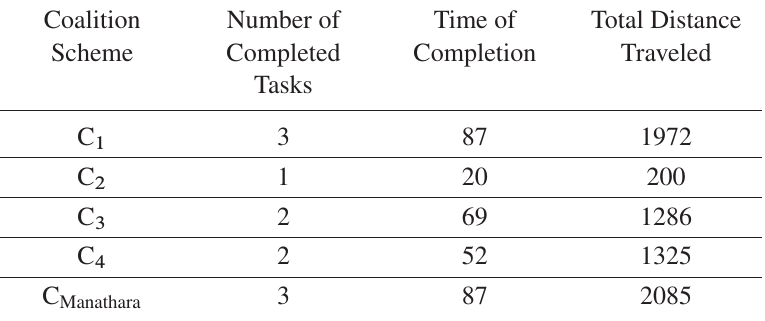
Table 2. Final fitness